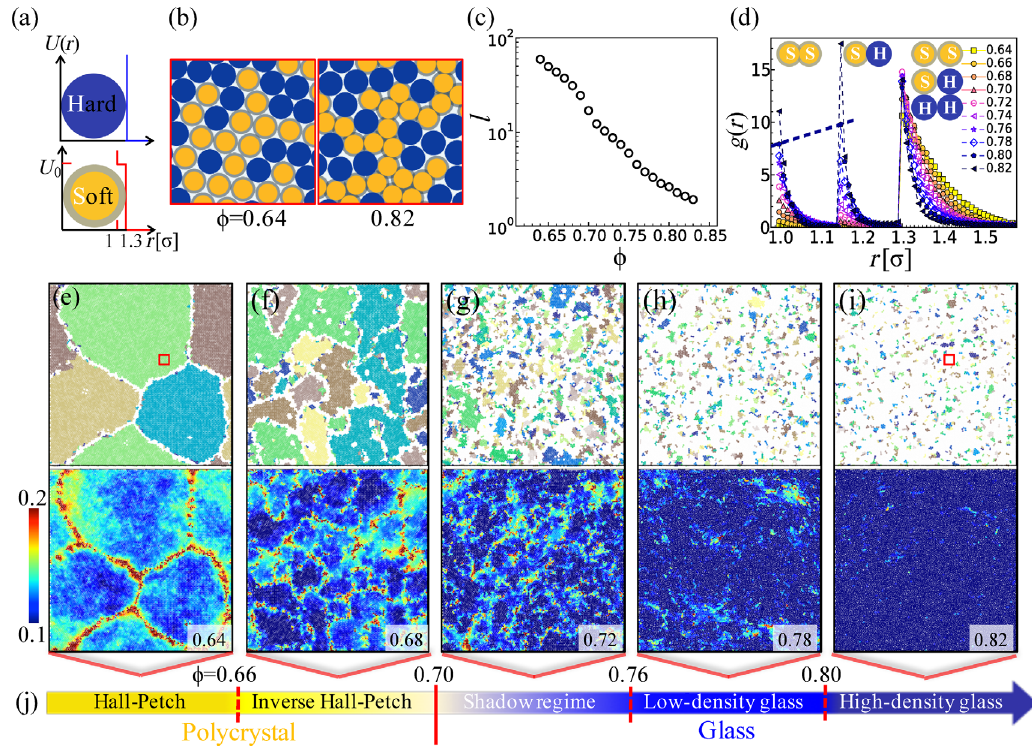
FIG. 1. The transformation of a binary polycrystal to a glass. (a) The interaction potentials of hard and soft disks. (b) Enlarged views of the regions marked by the small red boxes at ϕ ¼ 0 . 64 in (e) and ϕ ¼ 0 . 82 in (i). (c) Semilog plot of the weighted mean grain size l ð ϕ Þ . (d) The radial distribution functions g ð r Þ of the first-layer neighbors show three typical nearest-neighbor distances. (e) – (i) Structures (top) and dynamics (bottom) at ϕ ¼ 0 . 64 , 0.68, 0.72, 0.78, and 0.82, respectively, corresponding to the five regimes labeled in (j). Colors in the top panels show different grains and the white color marks the disordered particles. The bottom panels are colored according to the value of L (see Appendix C). The initial single crystal at ϕ ¼ 0 . 62 is shown in Fig. 11 in Appendix